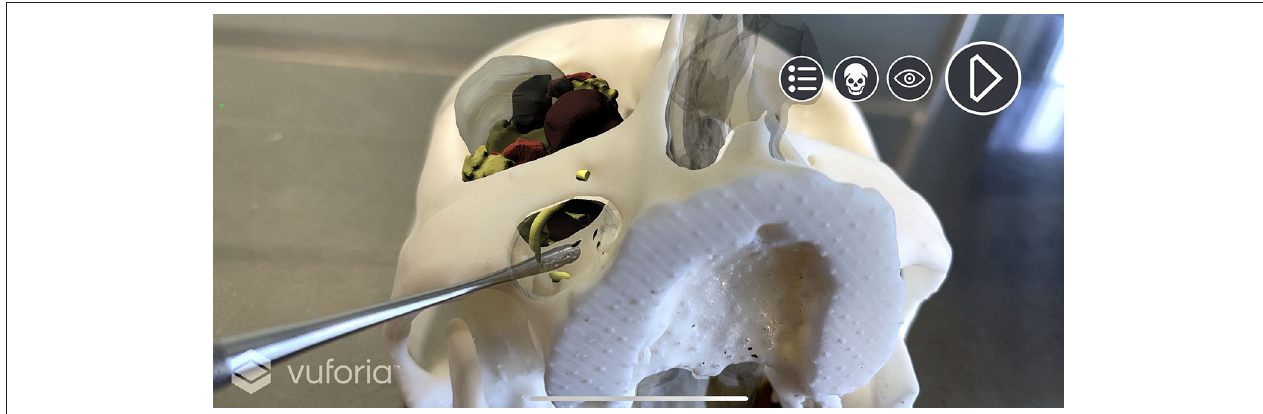
FIGURE 9 | “Holographic pre-surgical training.” Pre-operative simulation with computer-generated visual information. Surgical instruments can be used to simulate interaction with the virtual model of soft tissues during all phases of the simulated virtual endoscopic